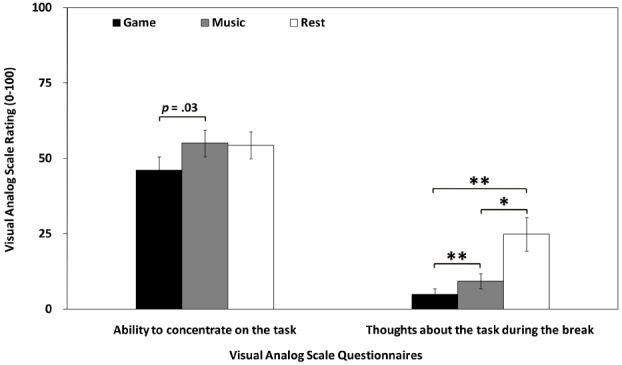
Mean self-rated visual analog scores for game, music and rest conditions. Visual analog scales (VAS) were adapted from Bond and Lader (1974). Error bars represent standard errors of the mean. *p < 0.02 and **p < 0.003 (two-tailed) after Bonferroni correction for multiple comparisons.